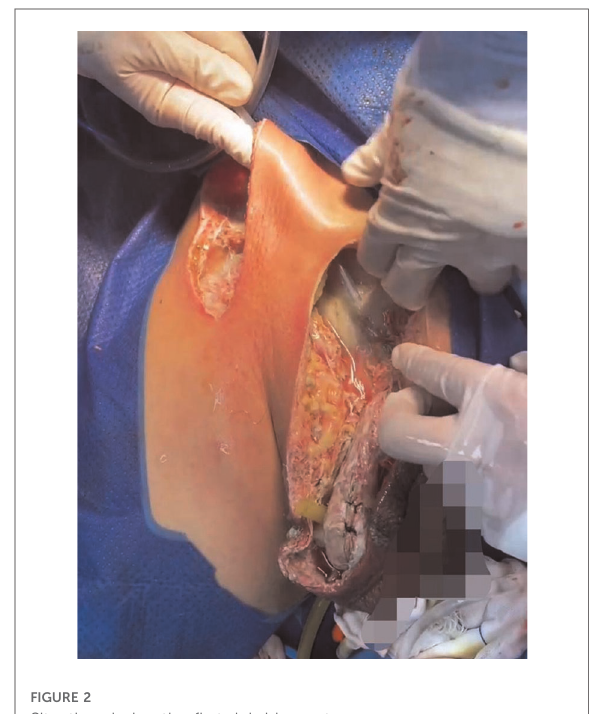
FIGURE 2 Situation during the fi rst